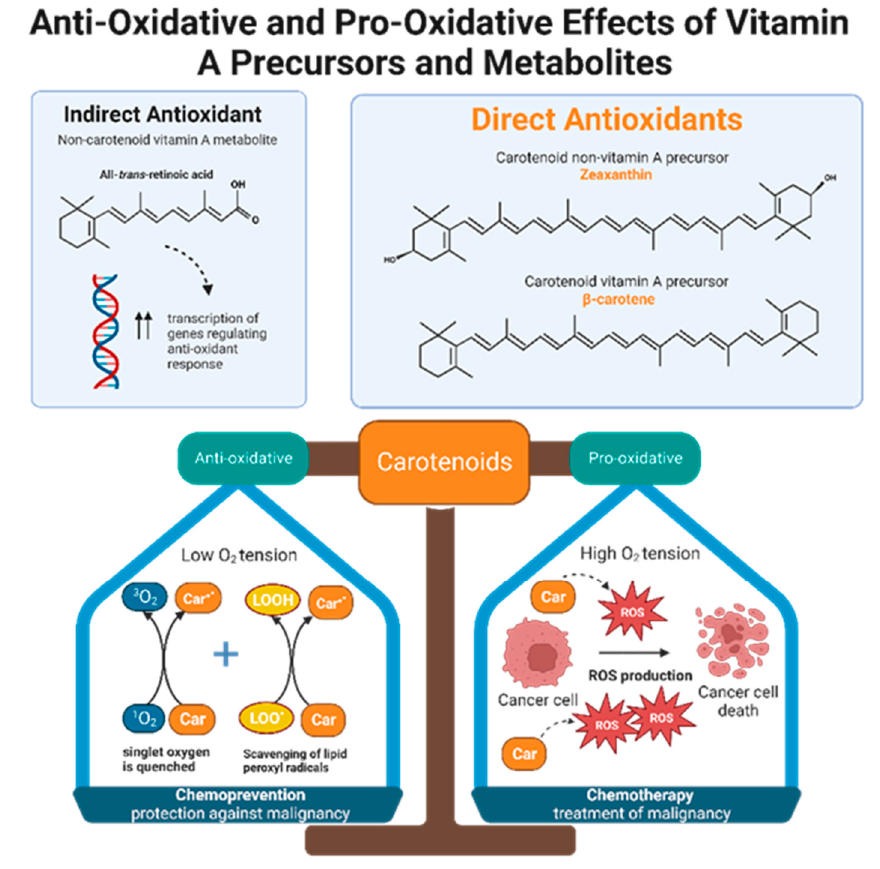
Figure 3. Non-carotenoid vitamin A precursors and metabolites include retinol, retinal, retinyl esters, and retinoic acid. Specifically, all-trans-retinoic acid demonstrates indirect antioxidant activity by increasing expression of gene products that enhance cellular response to oxidative stress. Carotenoids include both non-vitamin A and provitamin A precursors. Carotenoids, regardless of their vitamin A activity, exhibit direct anti-oxidizing abilities via radical scavenging and singlet oxygen quenching. Furthermore, carotenoids are dynamic agents that can produce either an anti-oxidative or pro-oxidative response, depending on the partial pressure of oxygen in the cellular environment. Malignant cells maintain high intracellular ROS levels, creating high oxygen tension. Under this condition, carotenoids exert a pro-oxidative response by increasing ROS production to generate oxidative stress that will kill cancer cells. This suggests that carotenoids have potential chemotherapeutic effects. In normal, non-neoplastic cells, carotenoids balance the production and elimination of ROS. This suggests that carotenoids may have a role in chemoprevention.